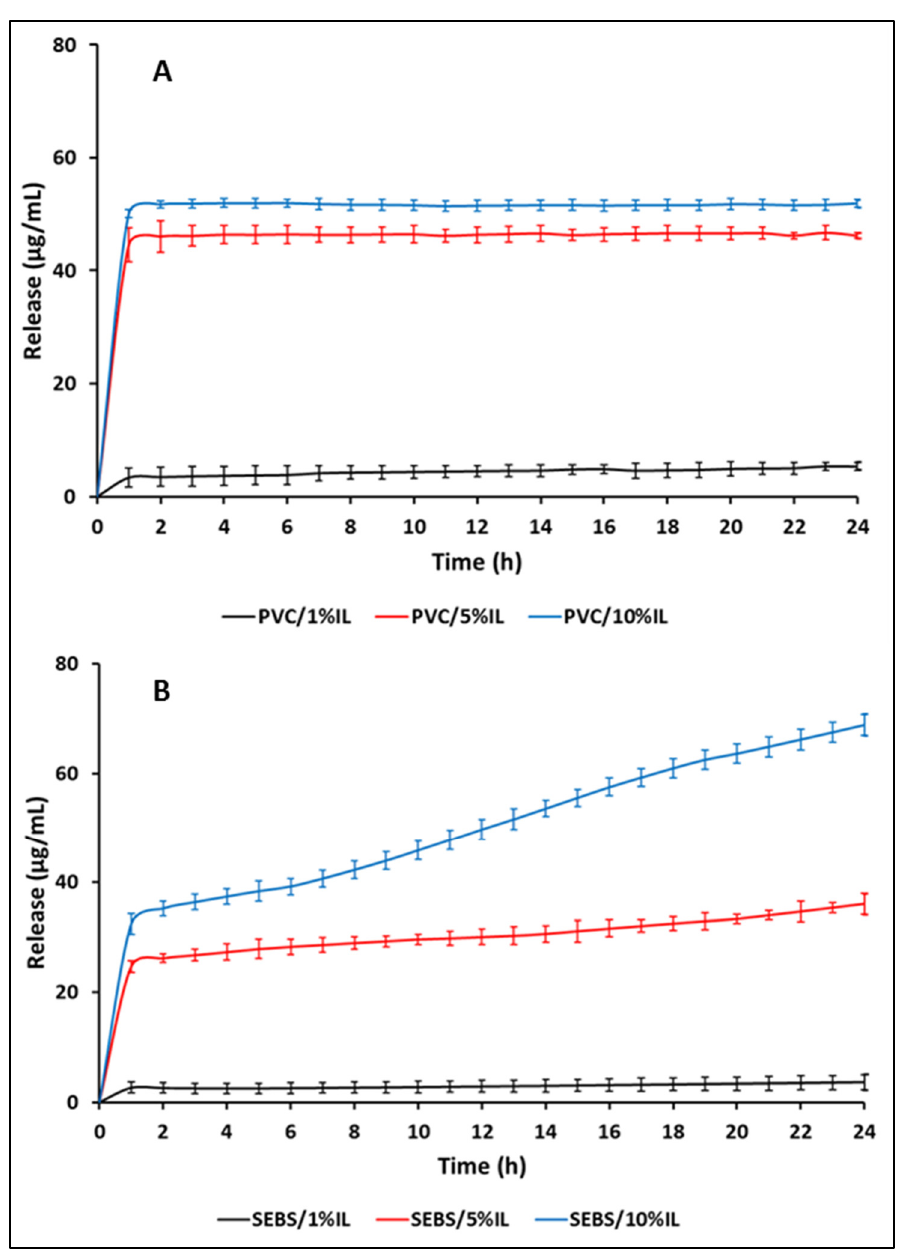
Figure 16. IL release from ( A ) PVC/HdmimDMSIP and ( B ) SEBS/HdmimDMSIP blends. Points are the mean of three independent replicates with n = 24 each. Bars represent ± SD.